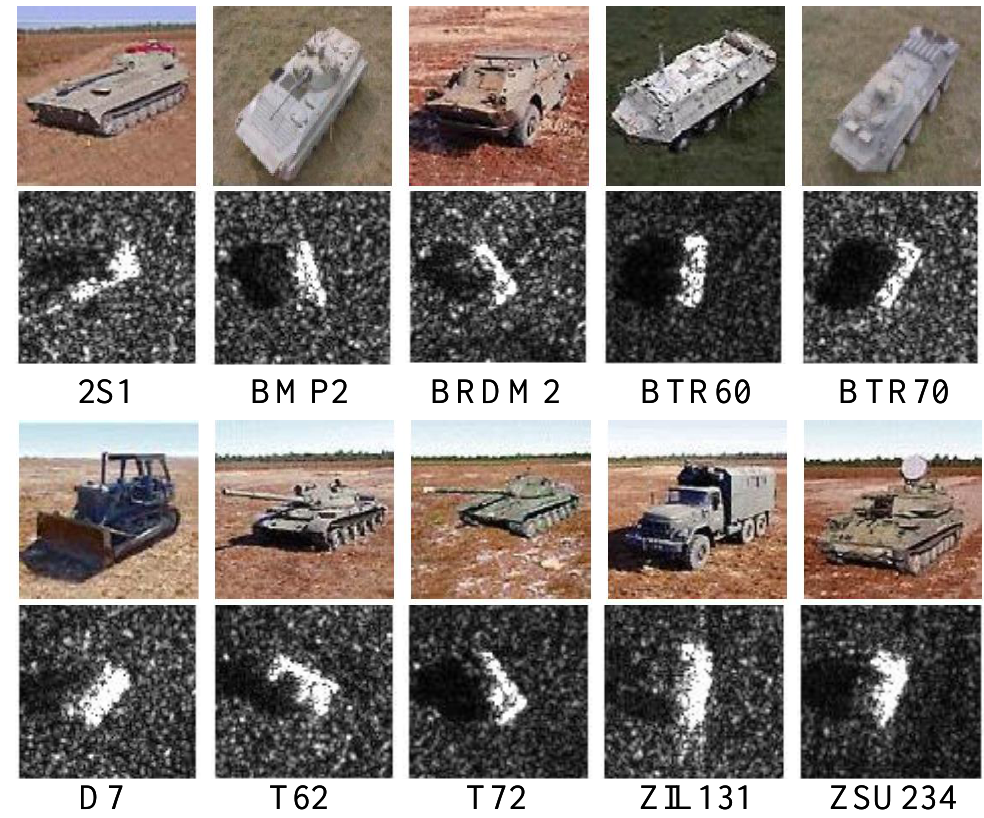
Figure 7. Optical images and corresponding SAR images of vehicles in the MSTAR